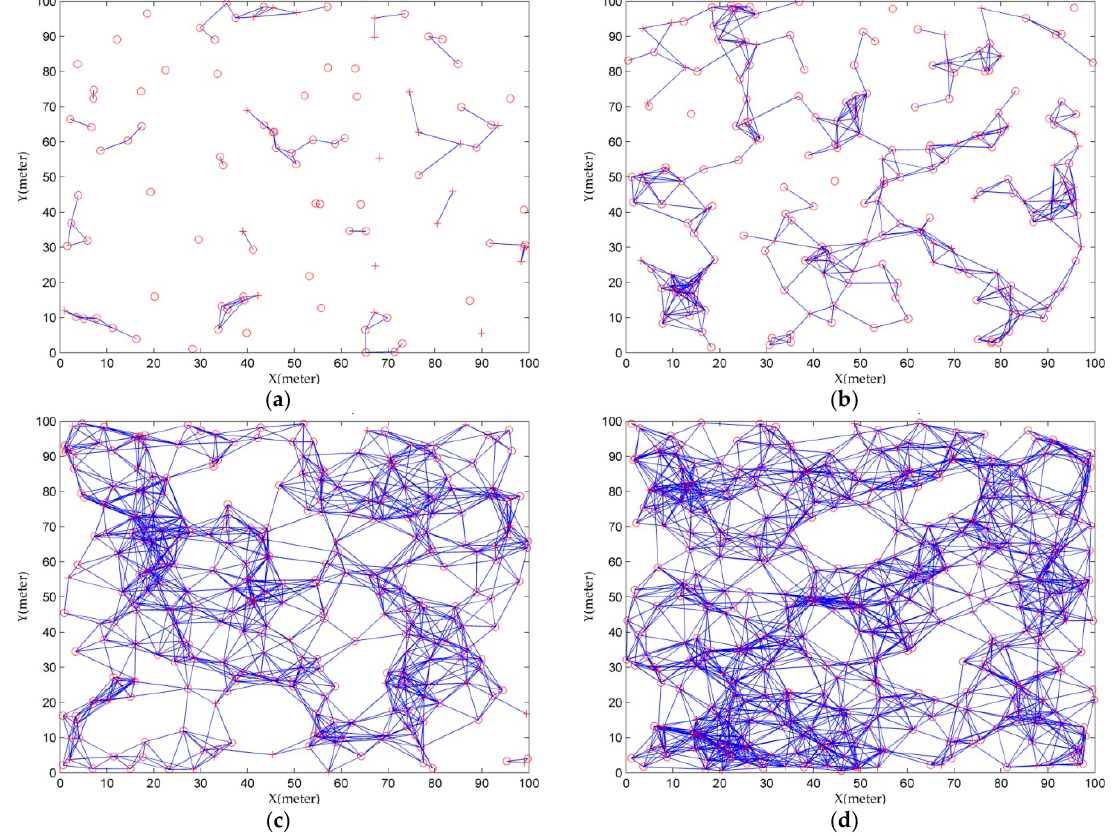
Figure 6. Example of network topology under different node density, ( a ) 100; ( b ) 200; ( c ) 300; ( d ) 400 when communication range is 10 m and the number of anchor nodes ( + ) is 20% of node density. In addition, the ( ◦ ) represents unknown nodes, the ( − ) represents the communication connectivity between sensor nodes.